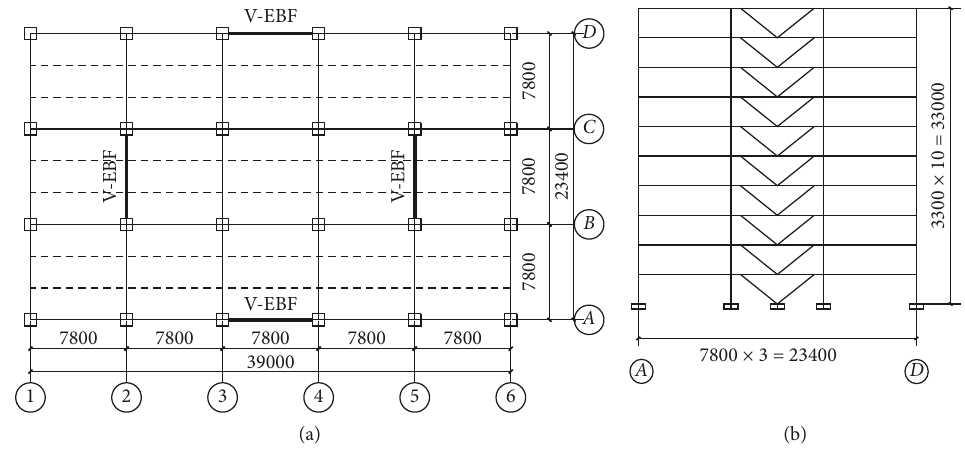
Figure 8: Structure (a) plane and (b) elevation views (unit: